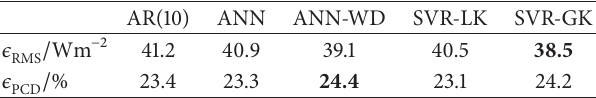
Table 2: Sixty-step ahead prediction results, for five different models, concerning a day with some cloud